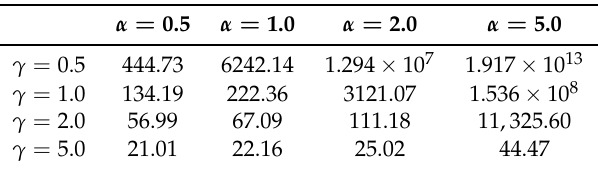
Table 2. Expected inspections before extinction